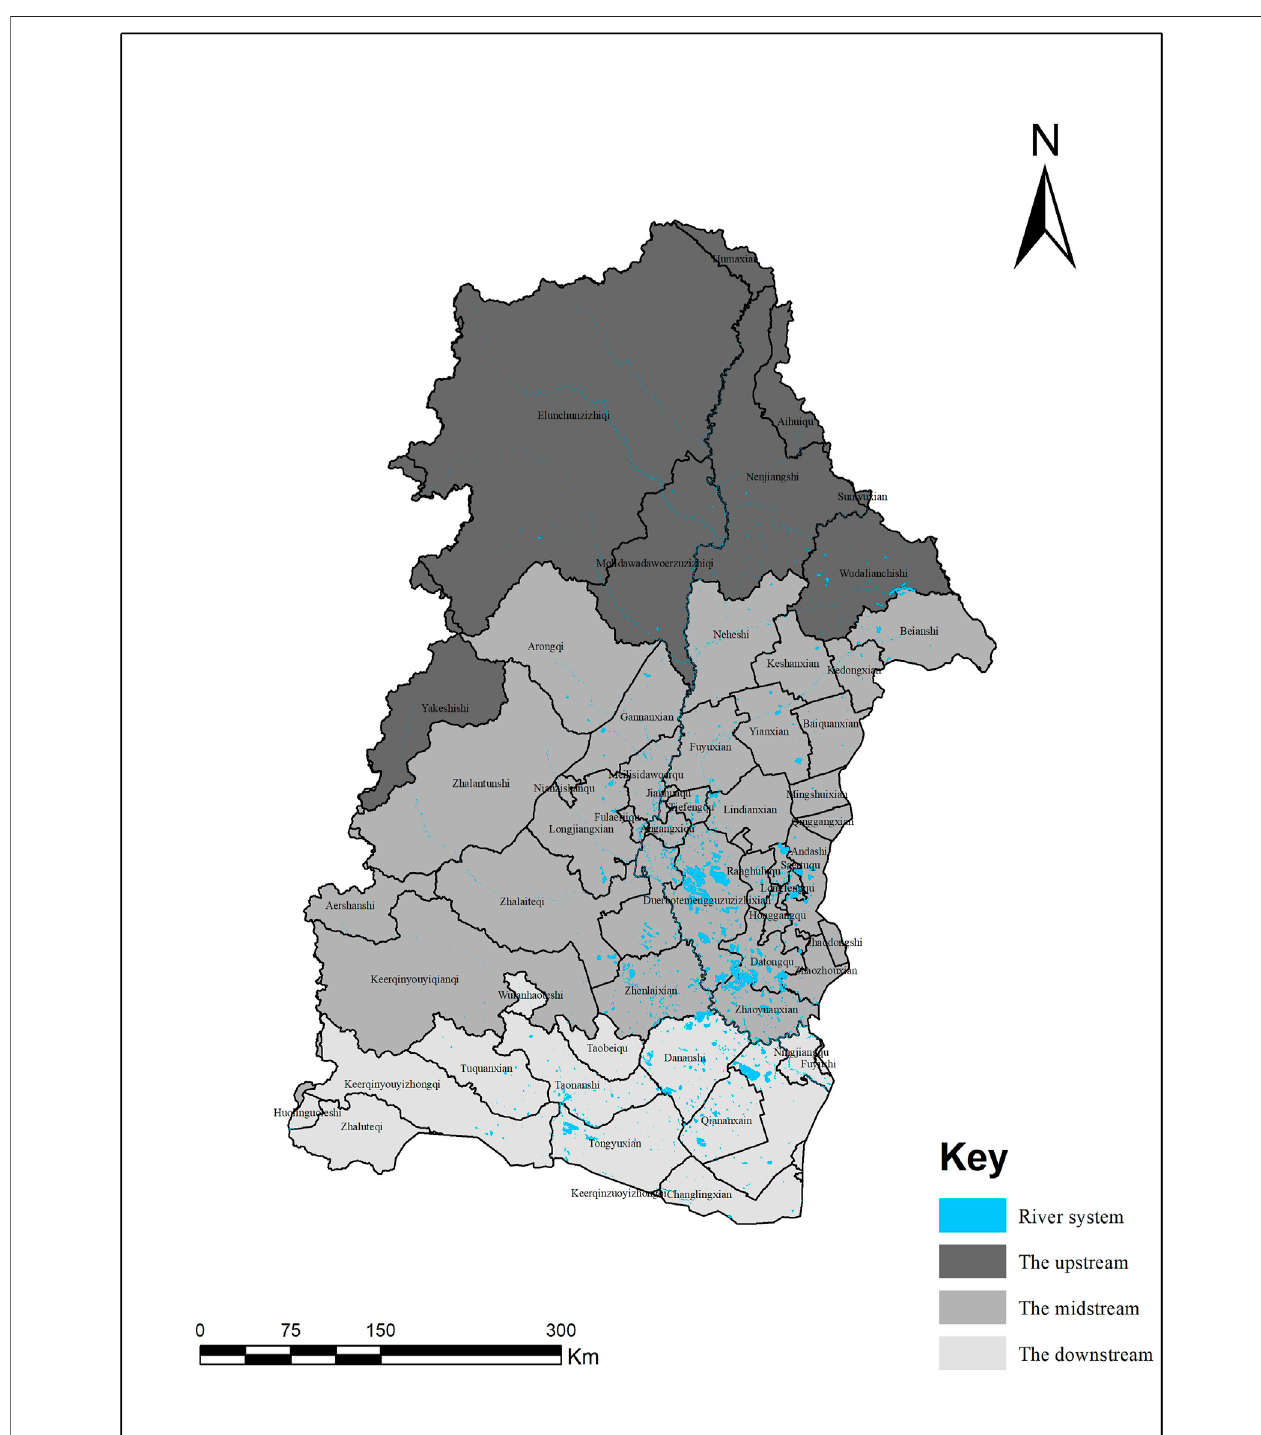
FIGURE 1 | Nenjiang river